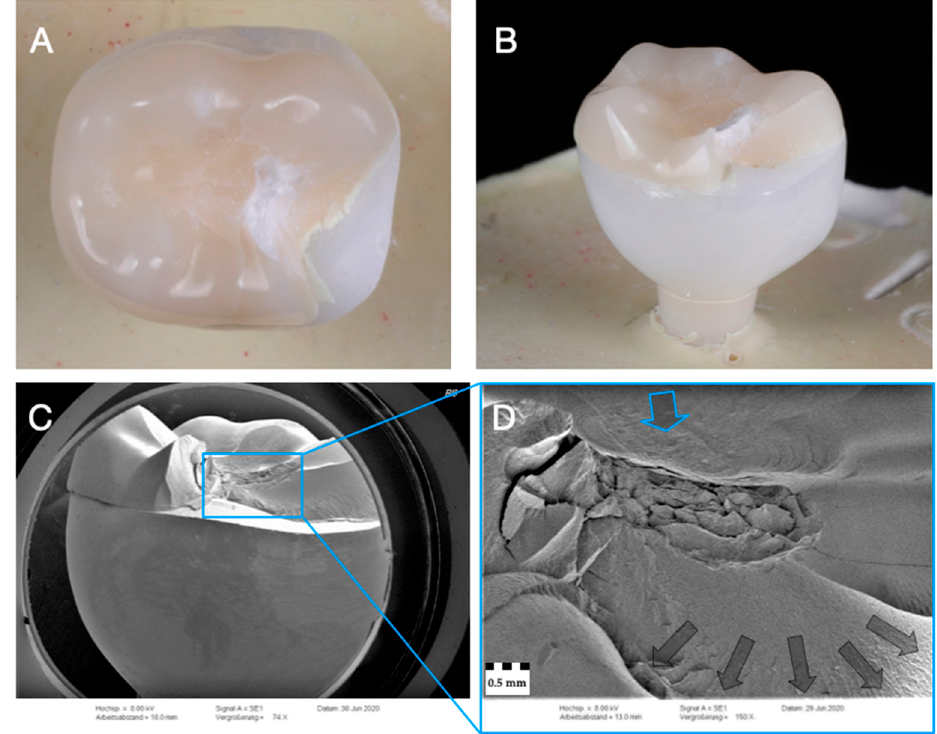
Figure 9. Representative specimen of Group RL after single-load-to-fracture assessment. Light microscopy shows ( A ) occlusal view of PICN table top chipping and ( B ) side view of fractured part. Note the intact underlying zirconia framework. SEM pictures: ( C ) overview of chipped PICN table top at low magnification with intact zirconia substructure. Detailed view at high magnification with complex crack course ( D ): blue arrow indicates fracture initiation point, while dark arrows represent the direction of crack propagation.